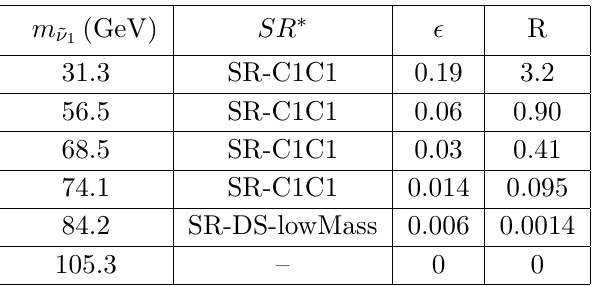
Table 3 . Detailed information about the analysis of 2 (cid:28) + E miss points. SR (cid:3) stands for the SR with the largest expected sensitivity, and (cid:15) is the net cut e(cid:14)ciency of the signal